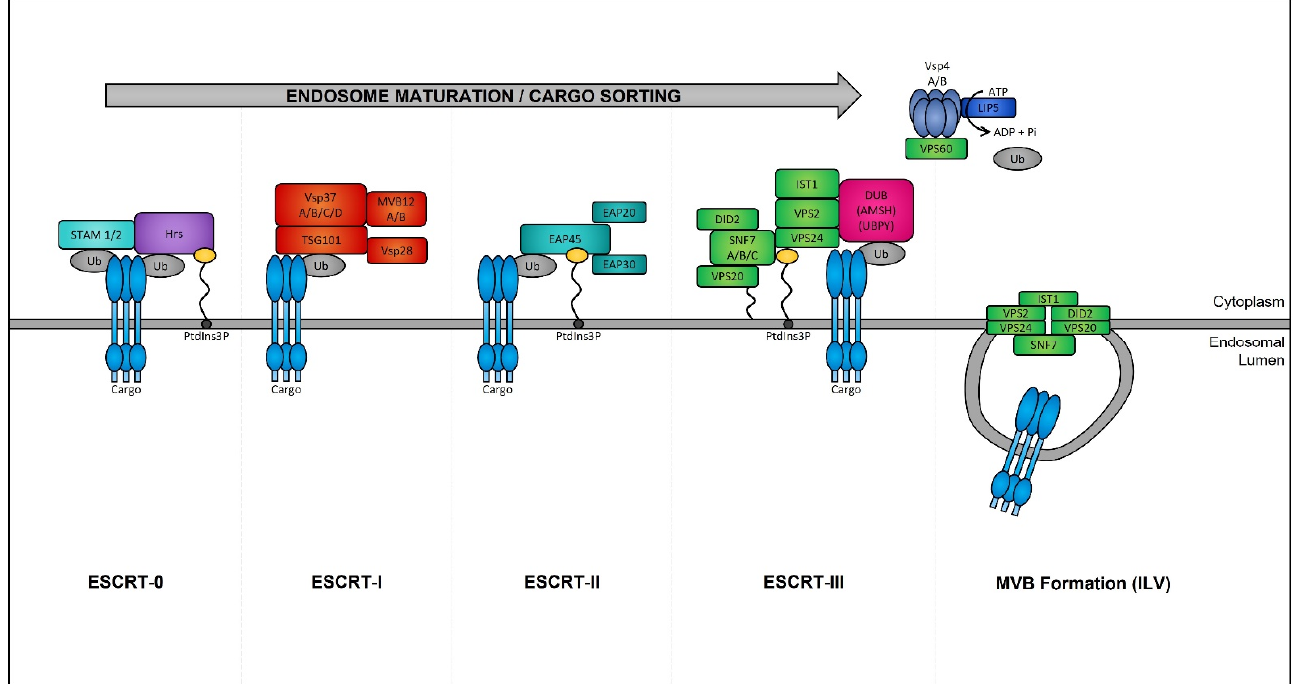
Figure 4. Endosomal sorting complexes required for transport (ESCRT)-dependent MVB formation. ESCRT-dependent MVB formation control the internalization of ubiquitinated proteins into the intraluminal vesicles (ILVs) of MVBs. The ESCRT complex is comprised of a series of sub-complexes which function uniformly during ILV production. ESCRT-0, -I, -II, and -III complexes function consecutively in a stepwise manner to control the selective sorting of ubiquitinated proteins into exosomes.